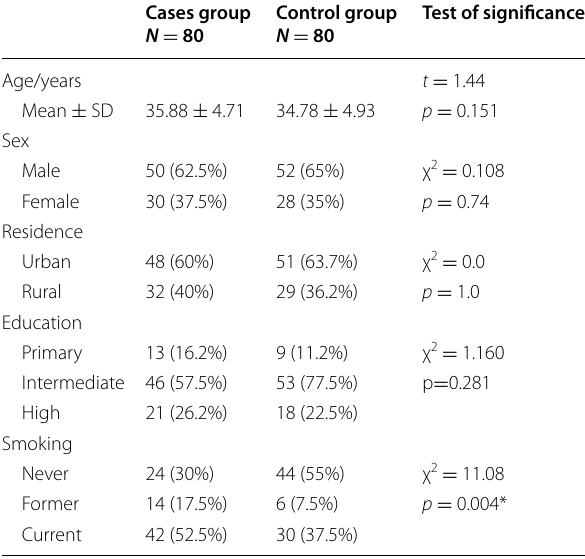
Table 1 Sociodemographic characteristics of the studied